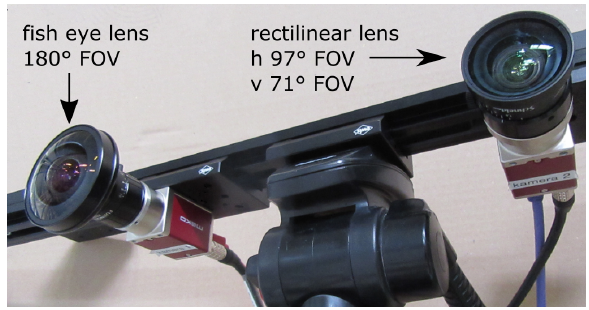
Figure 4. Bifocal camera rig with 21cm baseline.